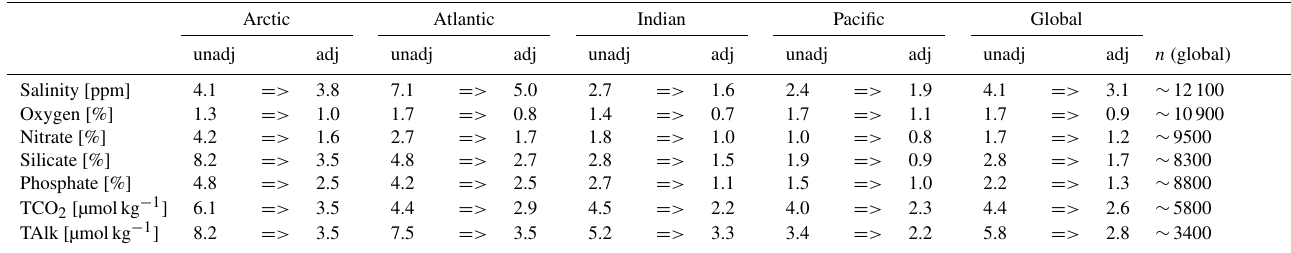
Table 5. Improvements resulting from the GLODAPv2 quality control split out per basin and for the global dataset. The numbers in the table are the weighted mean of the absolute offsets of all crossovers of unadjusted and adjusted data, respectively. n is the total number of valid crossovers in the global ocean for the variable in